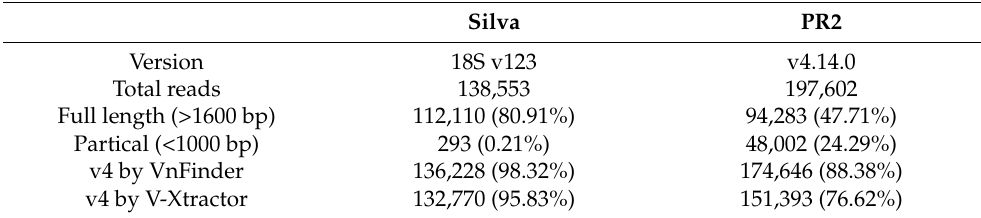
Figure 3. Information scale correction efficiency. ( A ) corrected reads number. ( B ) corrected read length. Table 2. Extraction performance in public